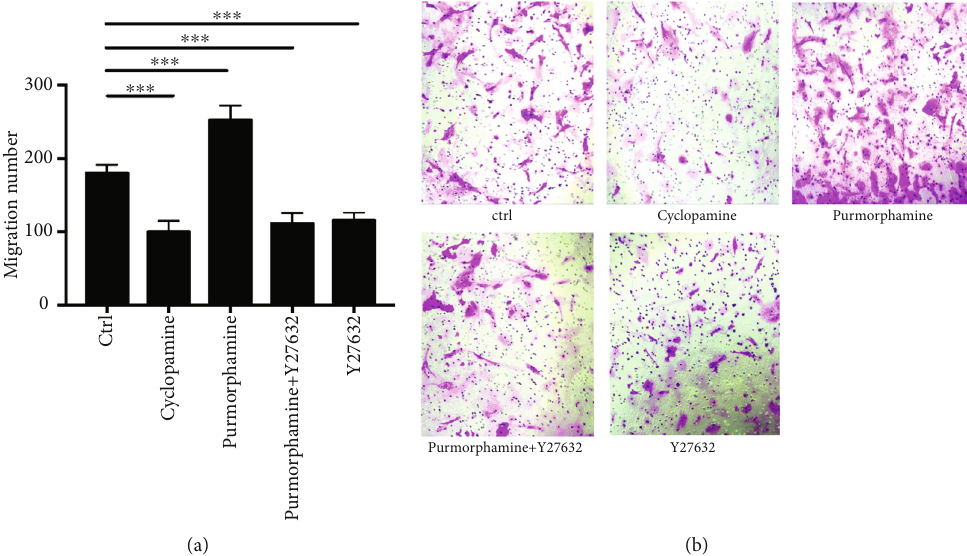
Figure 5: Shh signaling pathway regulates RA-FLS migration via Rho/ROCK pathway, tested with Transwell assays. RA-FLS were treated with purmorphamine, purmorphamine combined with Y27632, Y27632, or cyclopamine and the cell migration potency was evaluated with Transwell assays. (a) The photos of migrated RA-FLS were observed under an inverted microscope at 100x magni fi cation. (b) The numbers of migrated RA-FLS were calculated under the microscope and displayed with a histogramat. ∗∗∗ p < 0 : 001